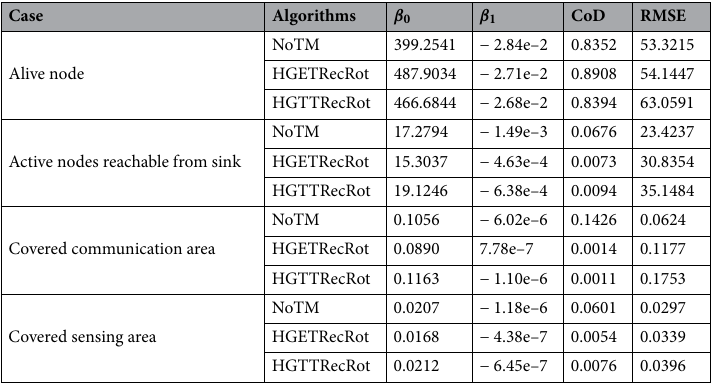
Table 3. The values of regression coefficients, CoD, and RMSE obtained from the prediction